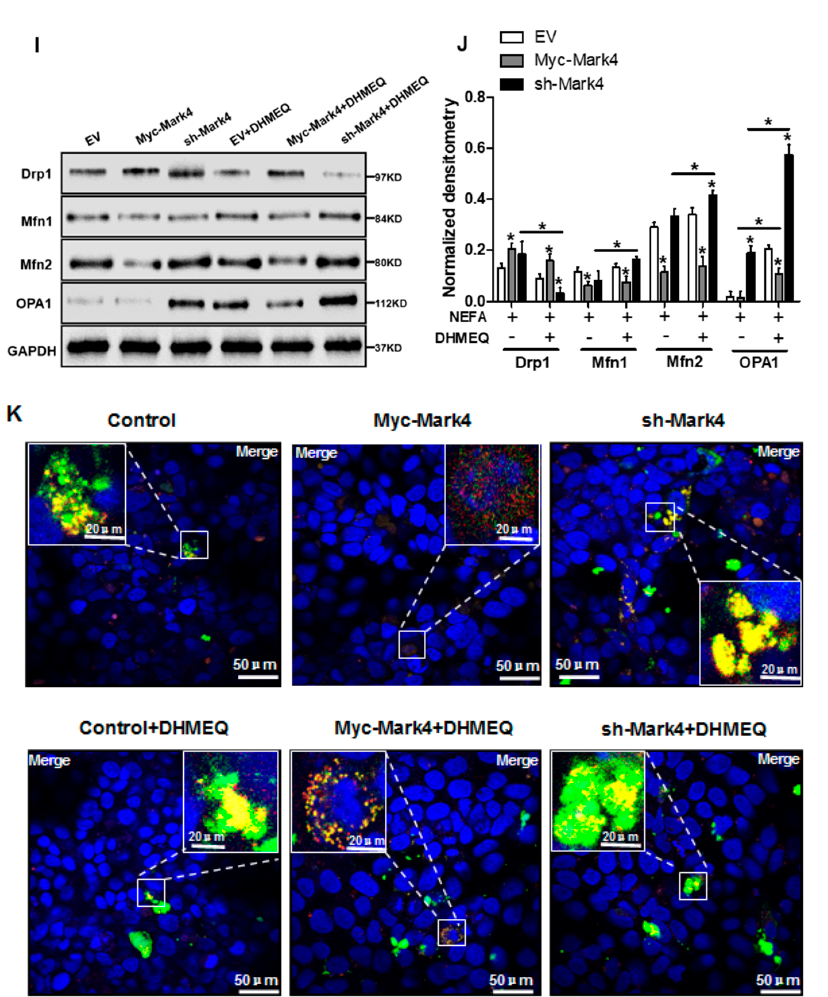
Figure 6. Activation of the NF- κ B pathway by MARK4 promotes oxidative stress and mitochondrial dysfunction in pig primary trophoblast cells. ( A , B ) Representative immunoblots and densitometric quantification for MARK4, phos-IKK α /IKK α and phos-NF- κ B/NF- κ B after transfection with Myc- MARK4 and sh-MARK4 for 48 h in cytotrophoblasts. Cells were then treated with 400 µ M NEFA or 50 µ M DHMEQ for 24 h ( n = 3). ( C ) ROS production in pig cytotrophoblasts ( n = 3). ( D ) Mitochondrial ATP production after transfection with Myc-MARK4 and sh-MARK4 for 48 h in cytotrophoblasts. Before the assessment, cells were treated with 400 µ M NEFA or 50 µ M DHMEQ for 24 h ( n = 3). ( E ) JC-1 fluorescent staining using flow cytometry in cytotrophoblasts ( n = 3). ( F ) mtDNA copy number was determined by real-time PCR using the 2 - ∆∆ Ct method in pig trophoblast cells ( n = 3). ( G ) Relative mRNA expression of genes implicated in mitochondrial biogenesis was determined by quantitative RT-PCR in pig trophoblast cells ( n = 3). ( H ) Transmission electronic microscopy images (magnification × 25,000) of mitochondria in cytotrophoblasts after transfection with Myc-Mark4 and sh-Mark4 for 48 h. Cells were then incubated with 400 µ M NEFA in the presence or absence of 50 µ M DHMEQ for 36 h. ( I ) Representative immunoblot analysis of mitochondrial fission and fusion-related regulators. ( J ) Densitometric analysis of corresponding proteins in ( I ) by normalization to GAPDH as an internal control ( n = 3). ( K ) The assessment of mitochondrial function associated with fission and fusion in cytotrophoblasts after transfection with Myc-MARK4, sh-MARK4, mito- pEGFP, and mito-DsRed2 for 48 h. Cells were then incubated with 400 μ M NEFA or 50 μ M DHMEQ for 24 h. Scale bar: 50 μ m or 20 μ m. Values are expressed as mean ± SEM. * p < 0.05 compared with the control group. ROS: reactive oxygen species; NEFA: non-esterified fatty acid; DHMEQ: NF- κ B specific-inhibitor; Myc-MARK4 group: over expression of MARK4 group; sh-MARK4 group: knock down of MARK4 group; Control: empty vector (EV) group. Red arrow: mitochondria.